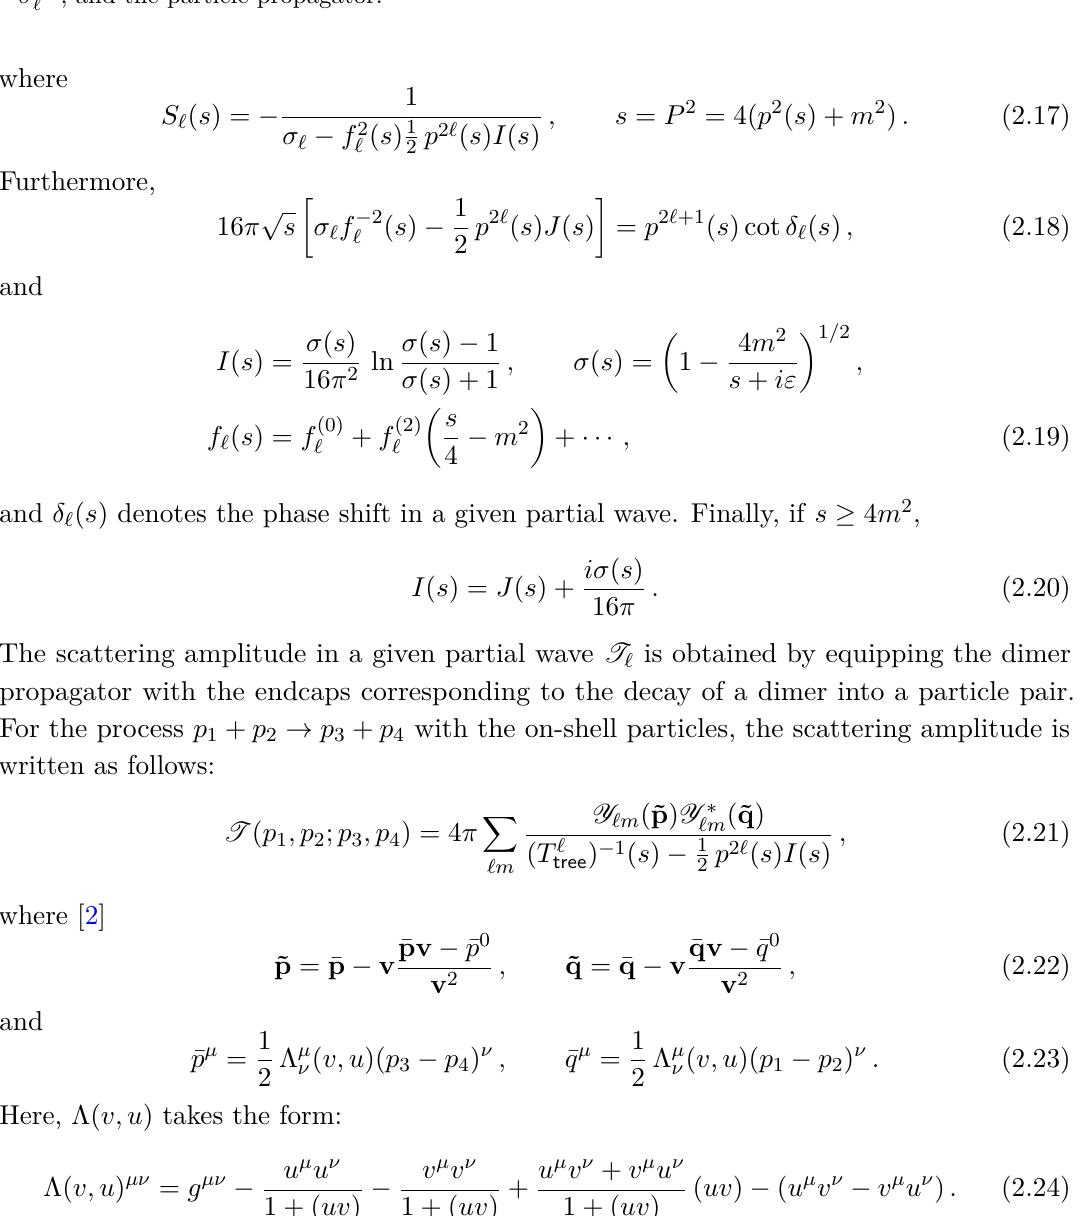
Figure 1 . Full dimer propagator, obtained by summing up self-energy insertions to all orders. The double, dashed and single lines denote the full dimer propagator, the free dimer propagator given by , and the particle − σ − 1 ‘